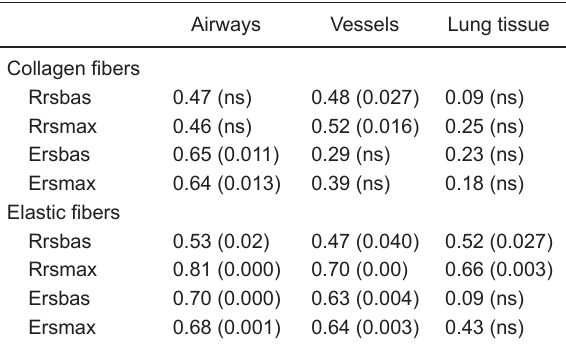
Table 1. Correlation matrix between functional parameters and collagen and elastic fibers in airways, vessels and lung